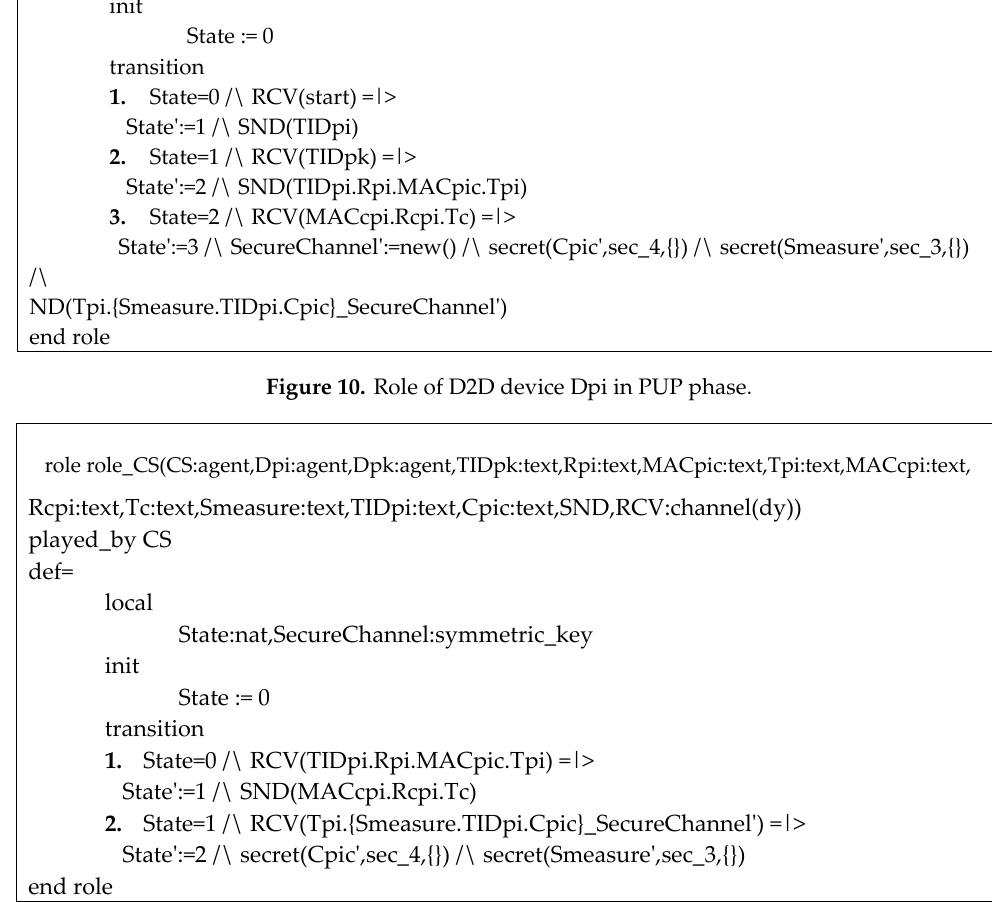
Figure 11. Role of the cloud server in PUP phase.